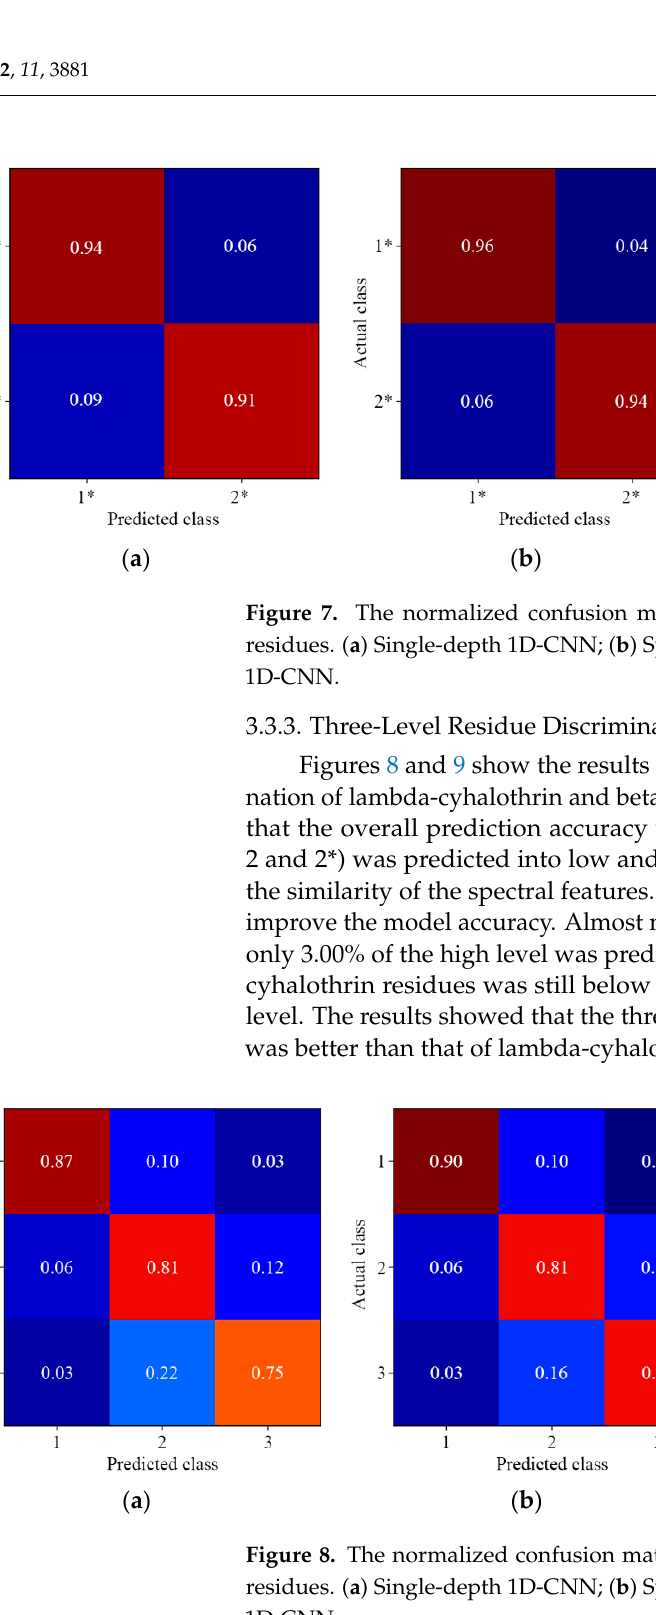
Figure 6. The normalized confusion matrix for two-level discrimination of lambda-cyhalothrin res- idues. ( a ) Single-depth 1D-CNN; ( b ) Symmetric multiscale 1D-CNN; ( c ) Asymmetric multiscale 1D-CNN.